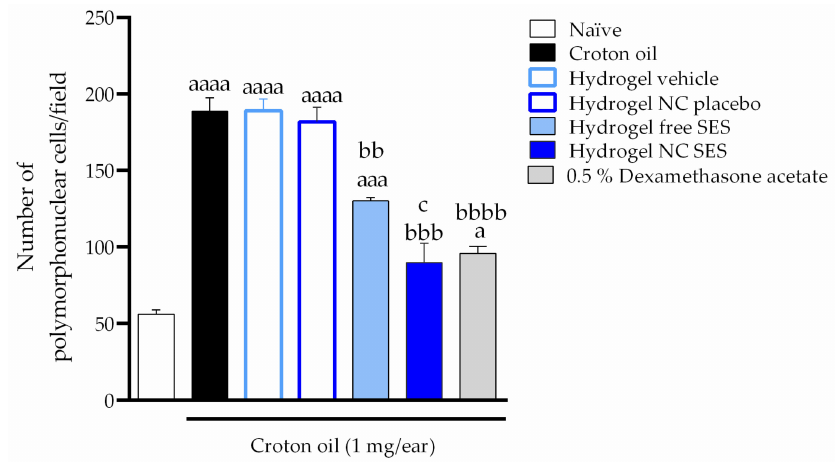
Figure 12. Effect of the hydrogels containing free or nanoencapsulated sesamol topically applied (15 mg/ear) on the polymorphonuclear cell infiltration in the croton-oil-induced ear edema in Swiss mice. Topical treatments were applied in mice ear immediately after the croton oil. The samples for the histological technique were collected 6 h after croton oil or croton oil plus treatments. Each bar represents the mean ± SEM ( n = 3); aaaa p < 0.0001, aaa p < 0.001 and a p < 0.05 show a significant difference when compared to the naïve group; bbbb p < 0.0001, bbb p < 0.001 and bb p < 0.01 show a significant difference when compared to the croton oil control group; c p < 0.05 shows a significant difference when compared to the Hydrogel free SES group. One-way ANOVA followed by post hoc Tukey’s